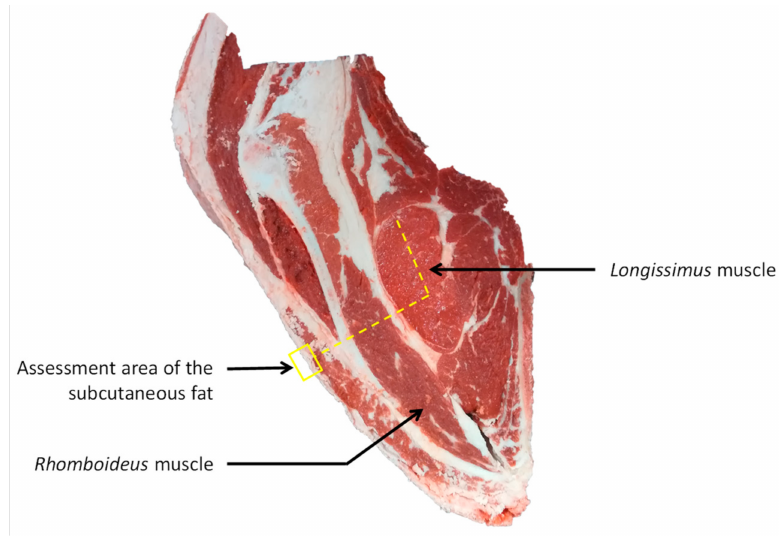
Figure 2. Localization of the longissimus and rhomboideus muscles on the cut section of the 6th rib and localization of the assessment area of the subcutaneous